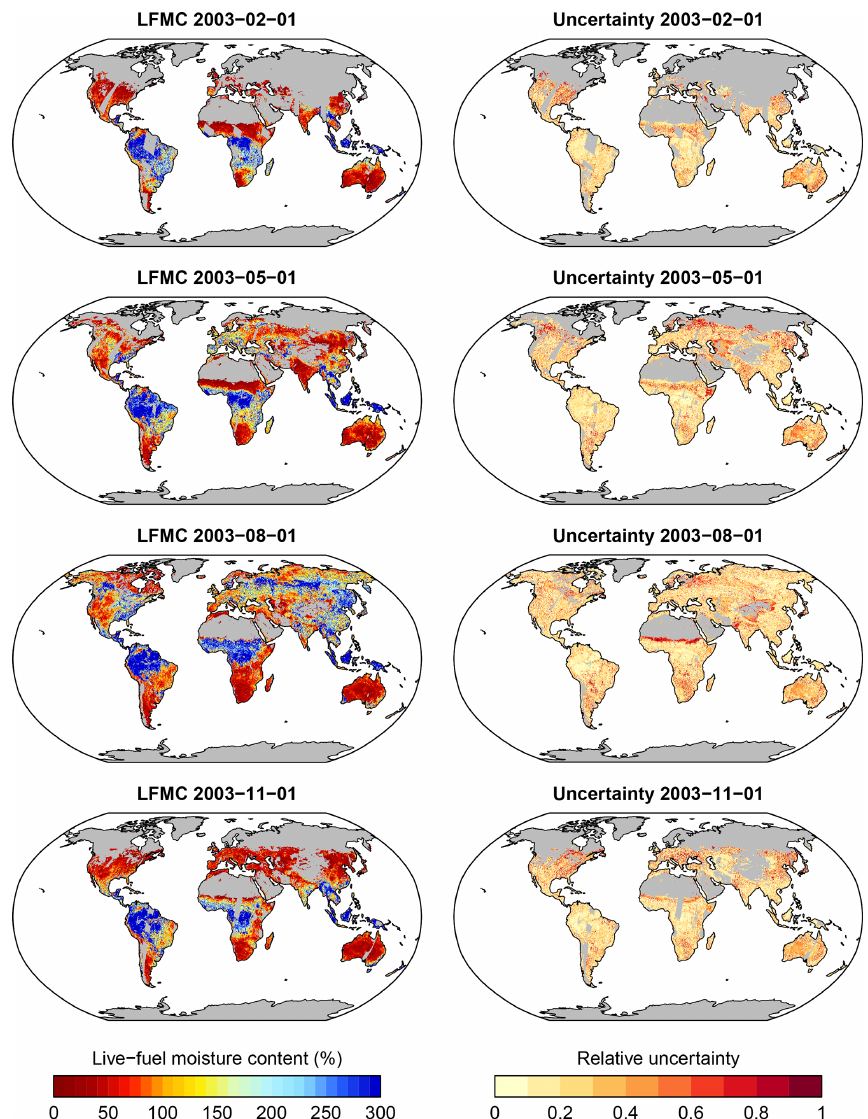
Figure 8. Example of global patterns of LFMC and associated uncertainties as estimated with Model B for 4 selected days in 2003, rep- resenting typical days during the northern seasons and the wet and dry seasons in Africa. Grey areas (missing data) is because of missing vegetation cover or gaps in the LAI or VOD